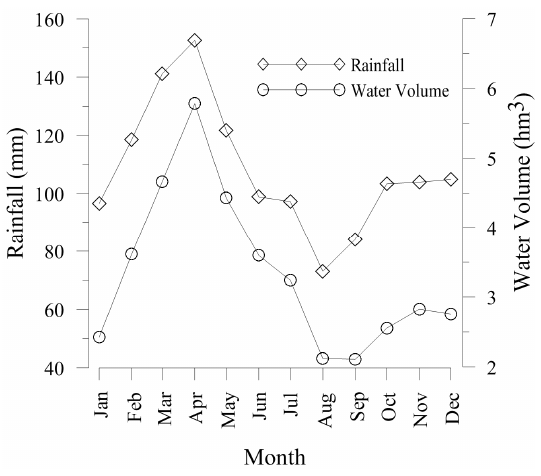
Figure 2. Monthly average of the time series of rainfall and water volume for the period 1971–2010.